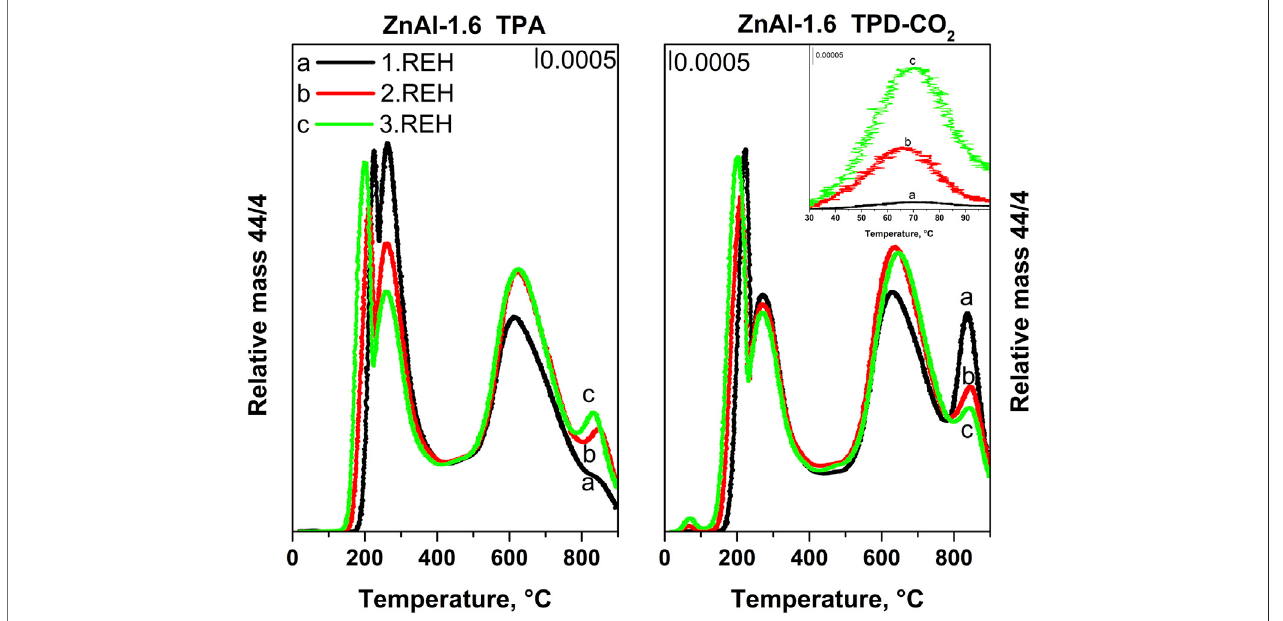
FIGURE 9 | TPA (experiment without CO 2 adsorption) and TPD-CO 2 pro fi les of ZnAl-1.6 RE-LDHs during repeating transformation of mixed oxide into reconstructed material: 1. REH – fi rst rehydration circle, 2. REH – second rehydration circle, 3. REH – third rehydration circle.